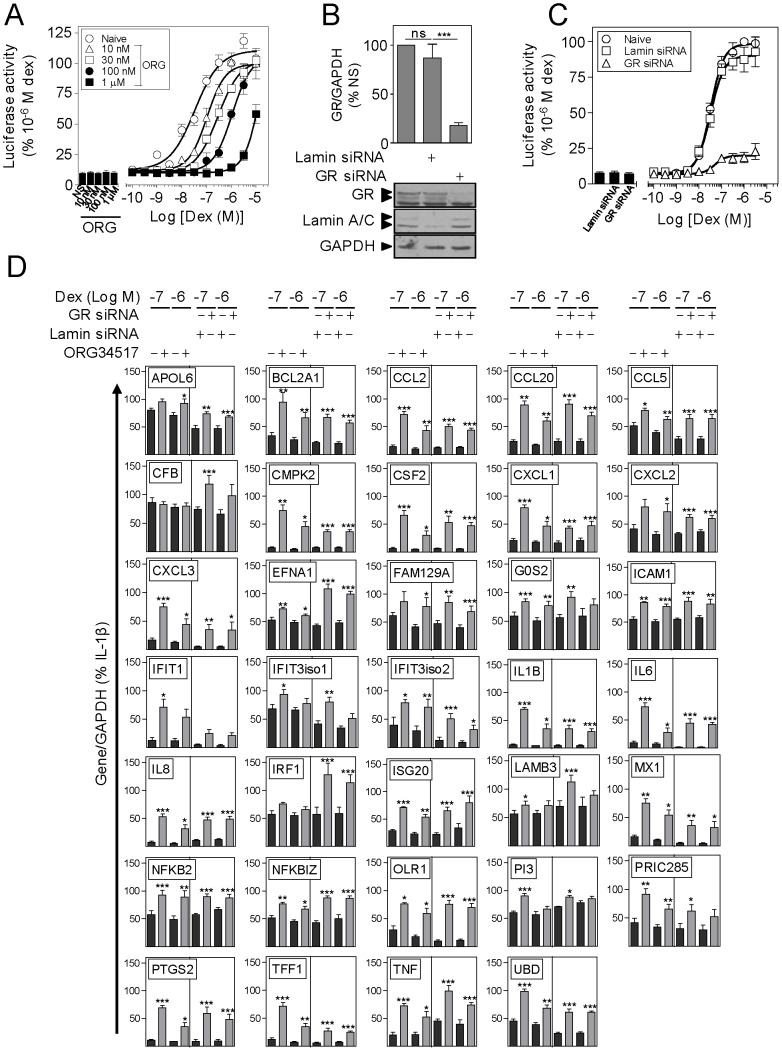
Effect of ORG34517 and GR-specific siRNA on repression of inflammatory gene expression by dexamethasone. A.A549 cells stably transfected with a 2×GRE reporter were incubated with the indicated concentrations of ORG34517 for 30 min prior to stimulation with increasing concentrations of dexamethasone (Dex) as indicated for 6 h. Cells were then harvested for luciferase assay. Data (n = 4–5) are expressed as a percentage of 1 µM dexamethasone and plotted as means ± SE. B. A549 cells were incubated with either lamin- (control) or GR-specific siRNA for 24 h prior to harvesting for western blot analysis of lamin A/C, GR and GAPDH. Following densitometric analysis, data (n = 5), normalised to GAPDH and expressed as percentage of NS are plotted as means ± SE. Significance, relative to lamin siRNA treated cells, using ANOVA with a Dunnet’s post-test, is indicated: ns, not significant; ***, P<0.001. Representative blots are shown. C. A549 cells stably transfected with a 2×GRE reporter were incubated with lamin- (control) or GR-specific siRNA for 24 h prior to stimulation with increasing concentrations of dexamethasone (Dex) as indicated. After 6 h, cells were harvested for luciferase assay. Data (n = 4–5) are expressed as percentage of 1 µM dexamethasone and plotted as means ± SE. D. A549 cells were either not treated or incubated with either ORG34517 for 30 min (left panel of each graph), or lamin- (control) or GR-specific siRNA for 24 h (right panel of each graph) prior to being either not stimulated (data not shown), or treated with IL-1β (1 ng/ml) in the absence (data not shown) or presence of either 0.1 or 1 µM dexamethasone (Dex) for 6 h. Cells were then harvested for real-time PCR analysis of the indicated genes and GAPDH. Data (n = 5–6) normalised to GAPDH and expressed as percentage of IL-1β are plotted as means ± SE. Left panel of each graph: significance relative to IL-1β+Dex was tested using a paired t-test and is indicated: *, P<0.05; **, P<0.01; ***, P<0.001. Right panel of each graph: significance relative to IL-1β+Dex+Lamin siRNA was tested using ANOVA with a Dunnett’s post test (see also Table S4) and is indicated: *, P<0.05; **, P<0.01; ***, P<0.001.